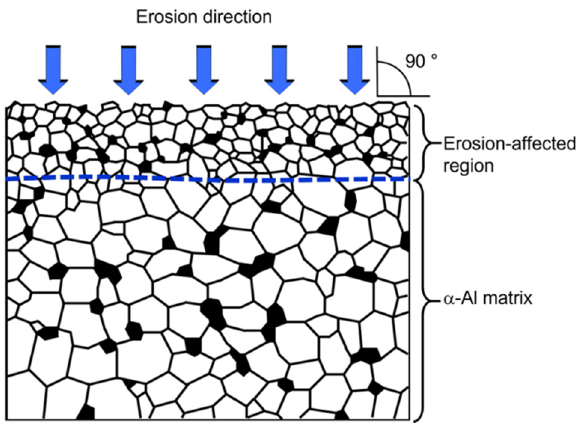
Figure 13. The schematic diagram of the structural characteristics and morphology of the phase transformation mechanism.